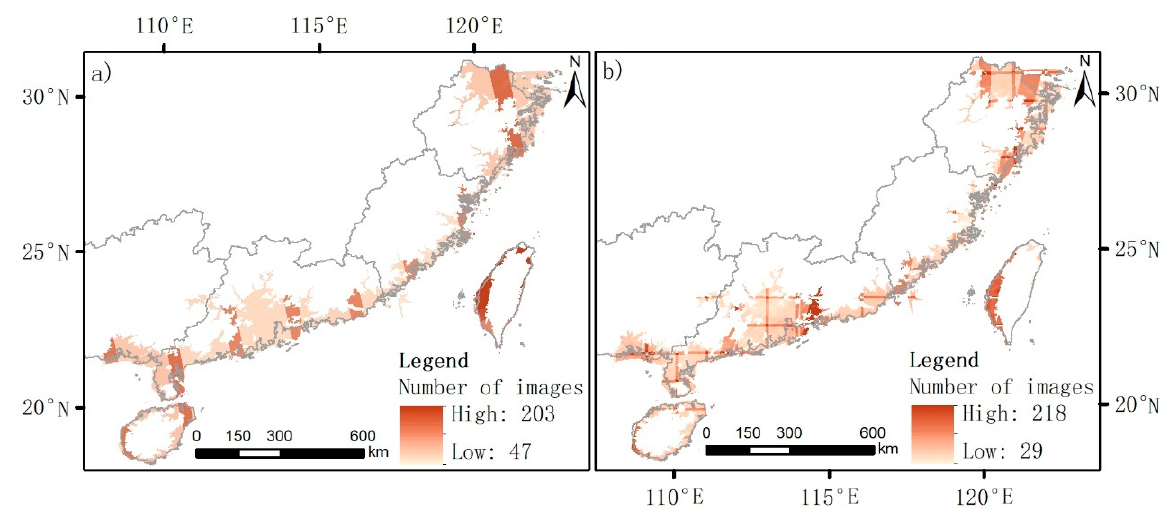
Figure 2. Number of Sentinel images per 10 m grid cell for ( a ) synthetic aperture radar (SAR) data; ( b ) multispectral instrument (MSI) data after masking clouds with the QA60 band.